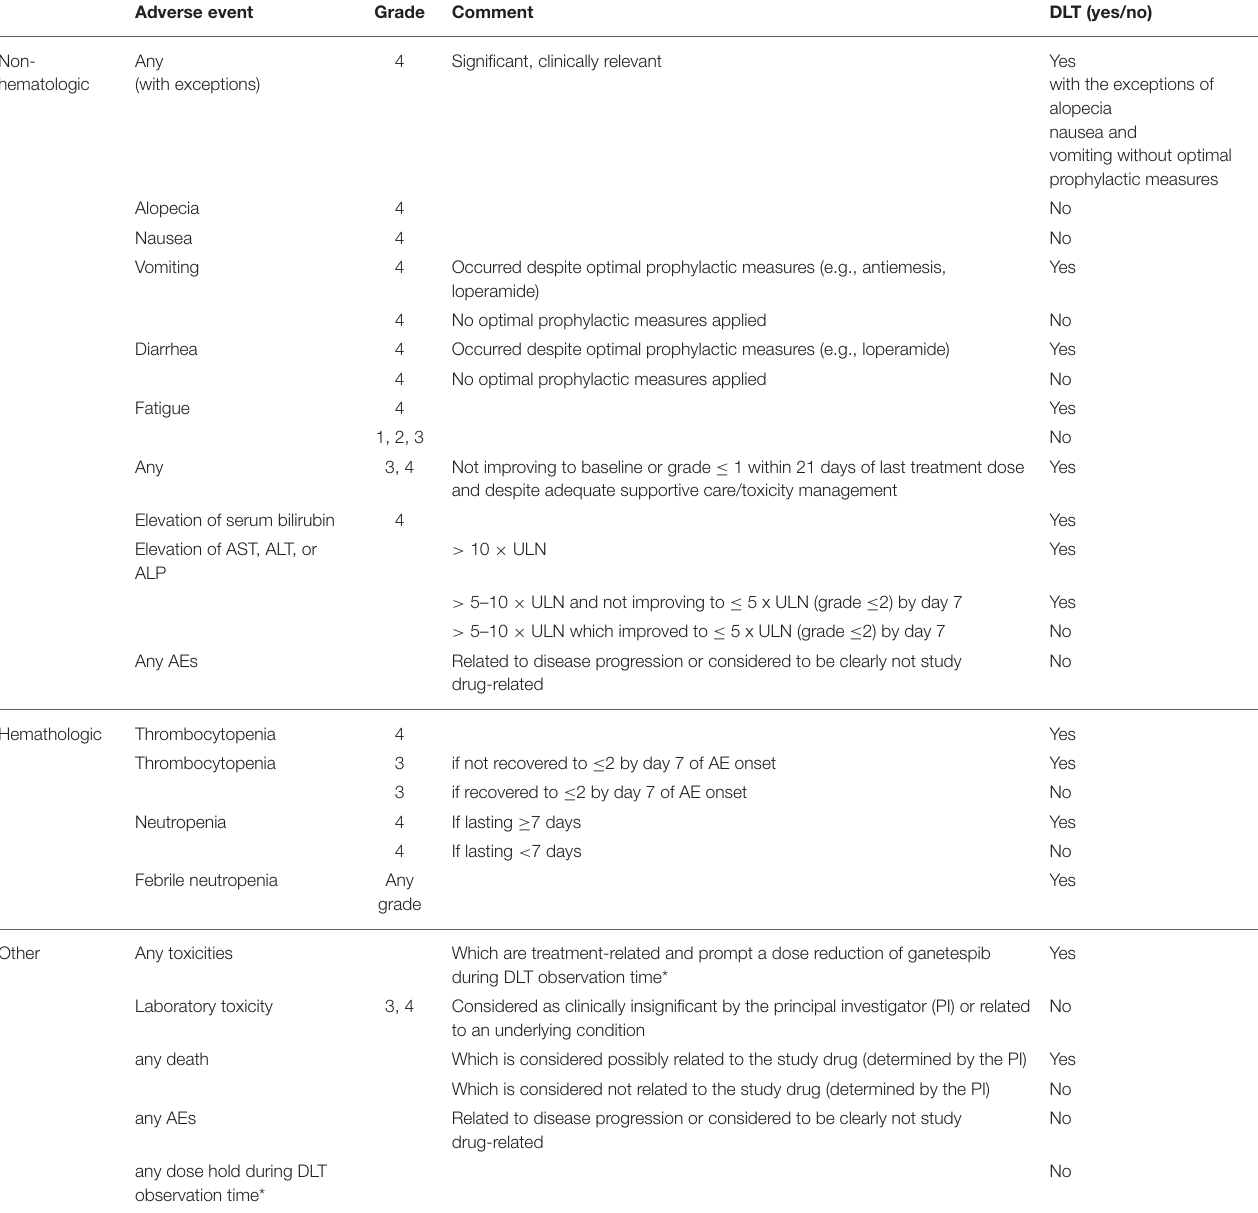
TABLE 1 | Criteria for dose-limiting toxicities (DLTs). Adverse event Grade Comment Non-